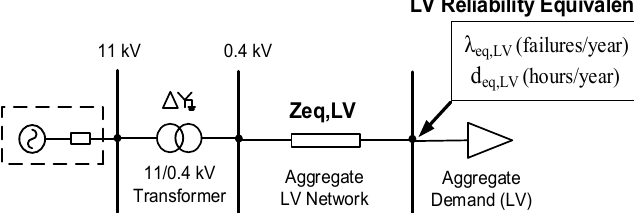
Figure 1. Aggregate representation of LV distribution network, showing the equivalent impedance, aggregate demand of all connected customers and reliability-equivalent model parameters.